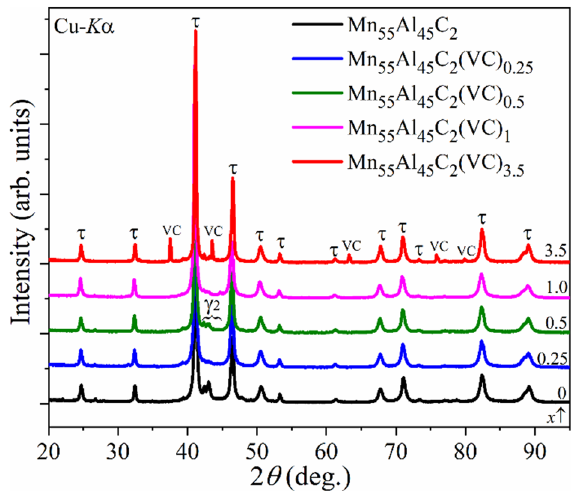
Figure 1. Comparison of the PXRD patterns for the as synthesized Mn 55 Al 45 C 2 (VC) x ( x = 0, 0.25, 0.5, 1 and 3.5) alloys.